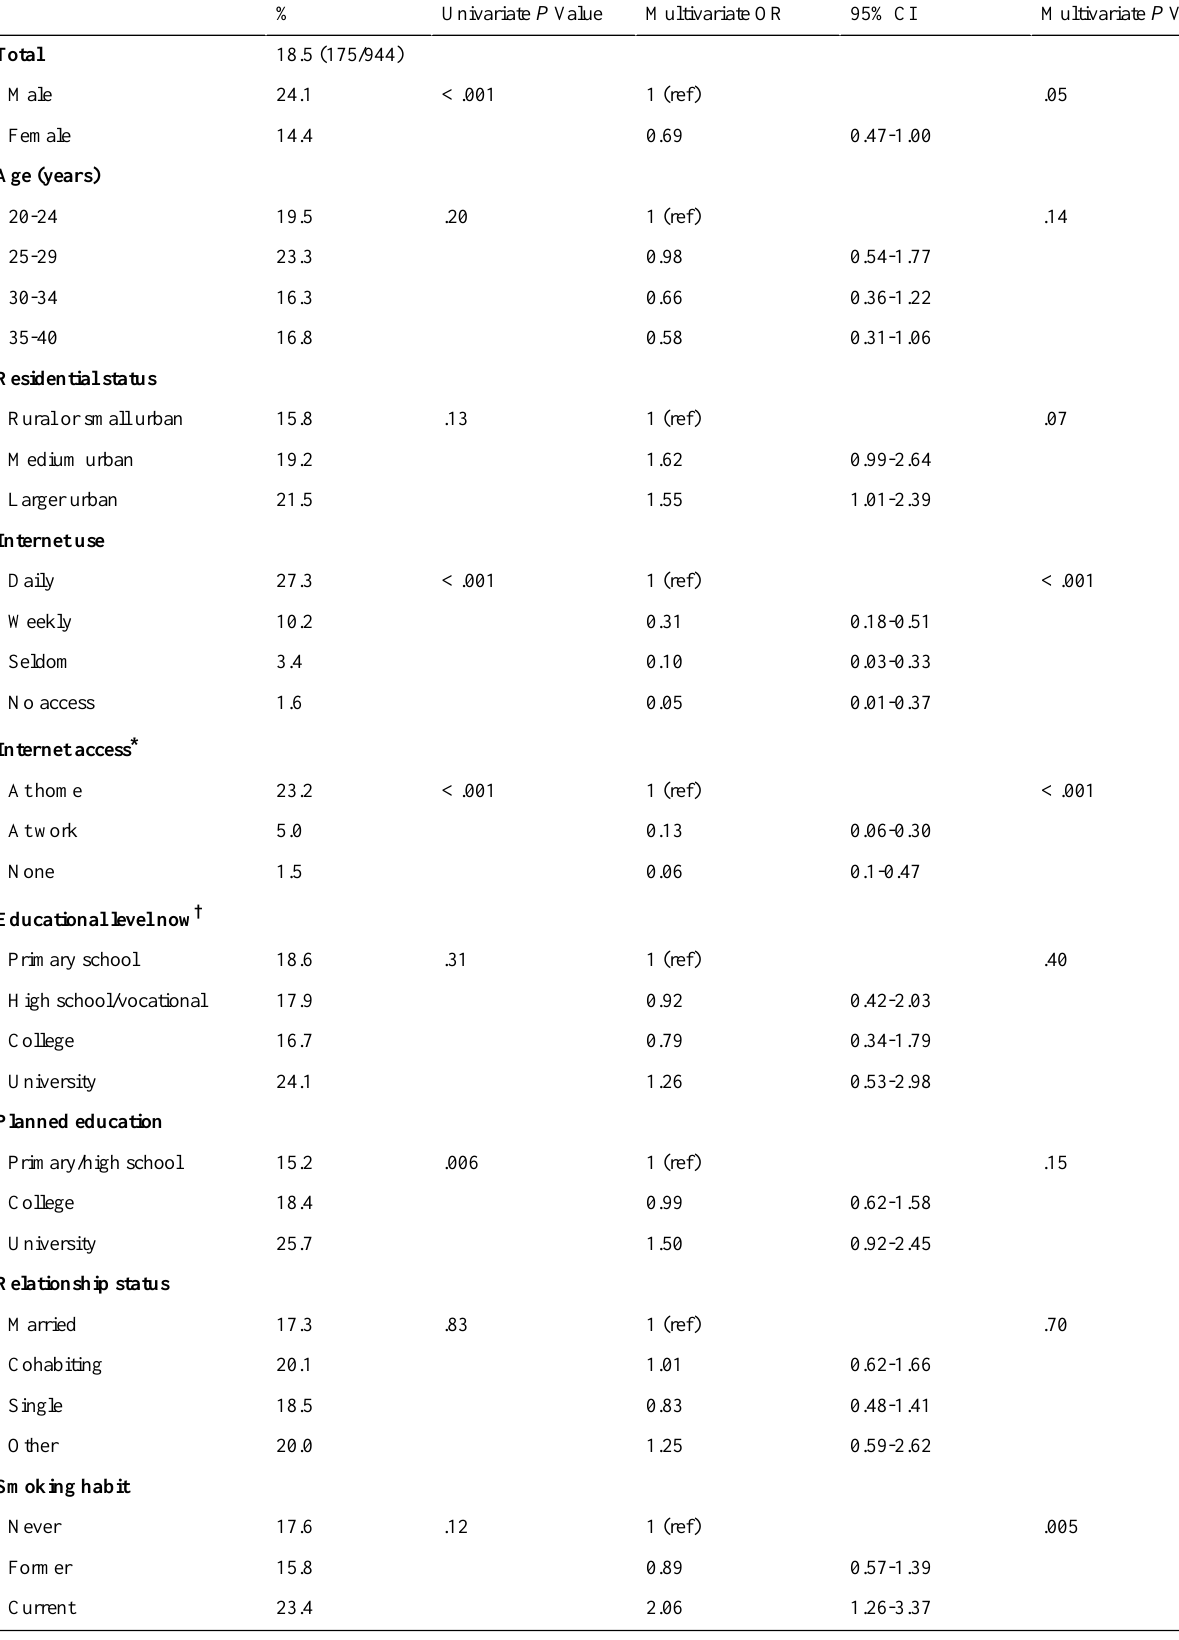
Table 3. Percent choosing the Internet response among respondents in the postal plus optional Internet arm (n =